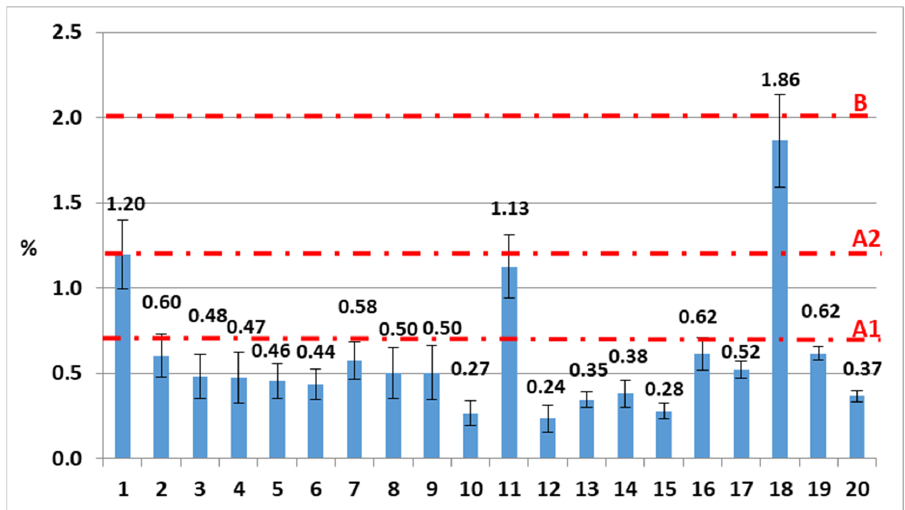
Figure 5. Mean ash content values (%) of pellets (the max. threshold of class A1 is 0.7, of class A2 is 1.2 and of class B is 2).